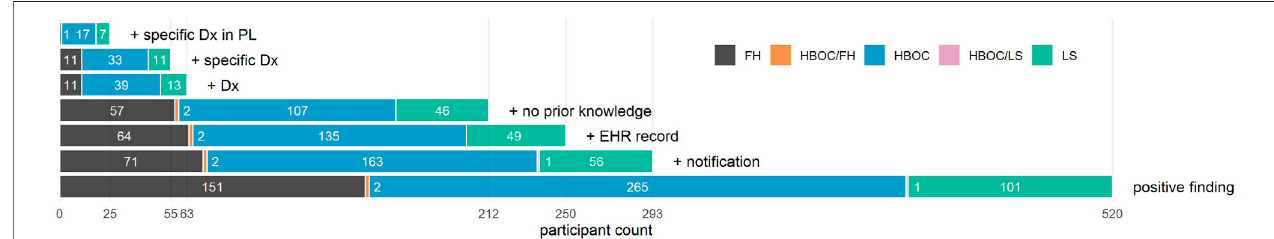
FIGURE1| Bargraphdepictingcountsofparticipantswhomeet increasinglyrestrictivecriteria.Frombottom totop, participantsarelimited to(1)thosewhohada positive fi nding for HBOC, LS, and/or FH; (2) those who were also noti fi ed of their fi nding and had a genetic consultation; (3) those who also had an EHR record at Renown; (4) those who also had no knowledge of their fi nding documented in their EHR prior to noti fi cation; (5) those who also had a relevant genetic diagnosis documented in their EHR after noti fi cation; (6) those whose diagnosis was speci fi c to their condition; and (7) those whose diagnosis appeared in their problem list. Total participant counts for each additional criterion appear on the x -axis, while counts for each distinct condition (or set of conditions) are superimposed on each